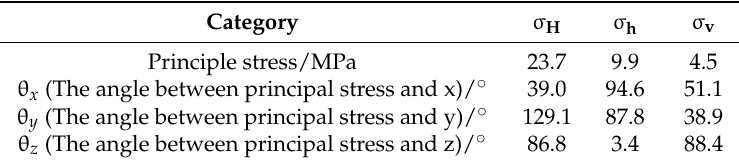
Table 2. Test result of in ‐ situ stress in Tonghua coalmine [25].